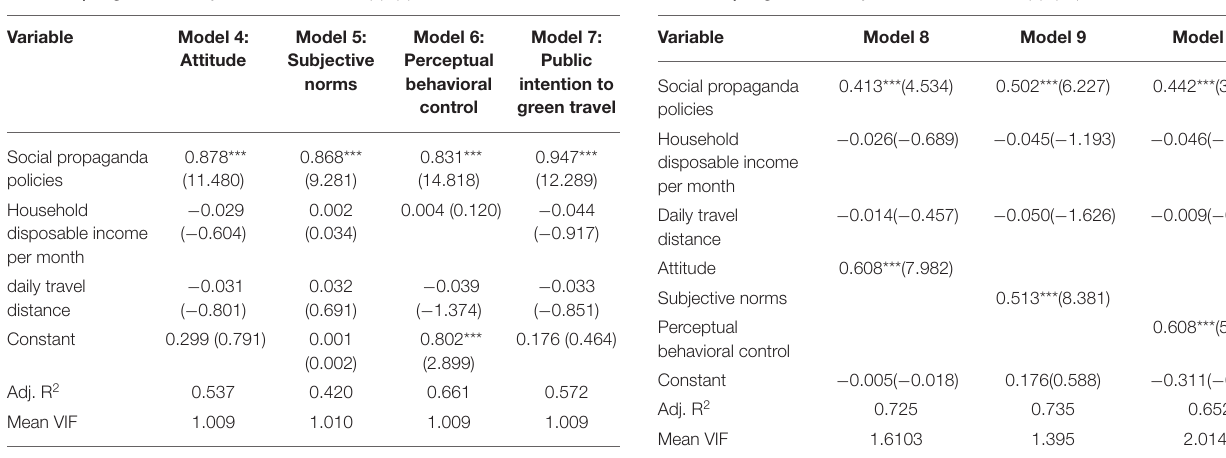
TABLE 4 | Regression analysis results of model (4)–(7). TABLE 5 | Regression analysis results of models